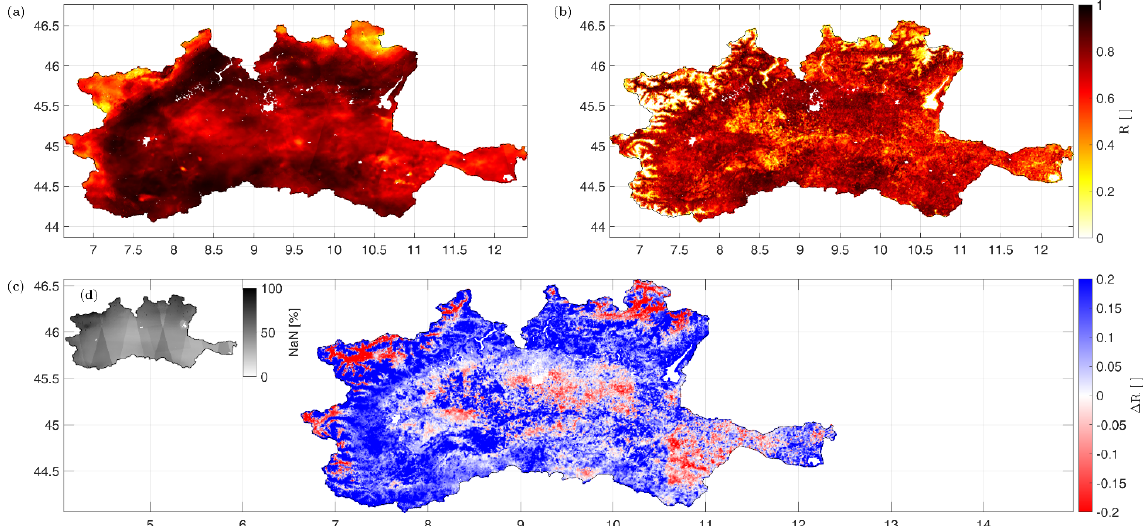
Figure A2. Spatial Pearson’s correlation (R) between the 30d accumulated rainfall derived from MCM and the application of the parame- terized SM2RAIN to ASCAT (a) and to S1-RT1 (b) SM products, only considering the periods for which all three products are available. Panel (c) shows the difference between ASCAT and S1-RT1 correlation maps, while panel (d) shows the percentage of invalid images per